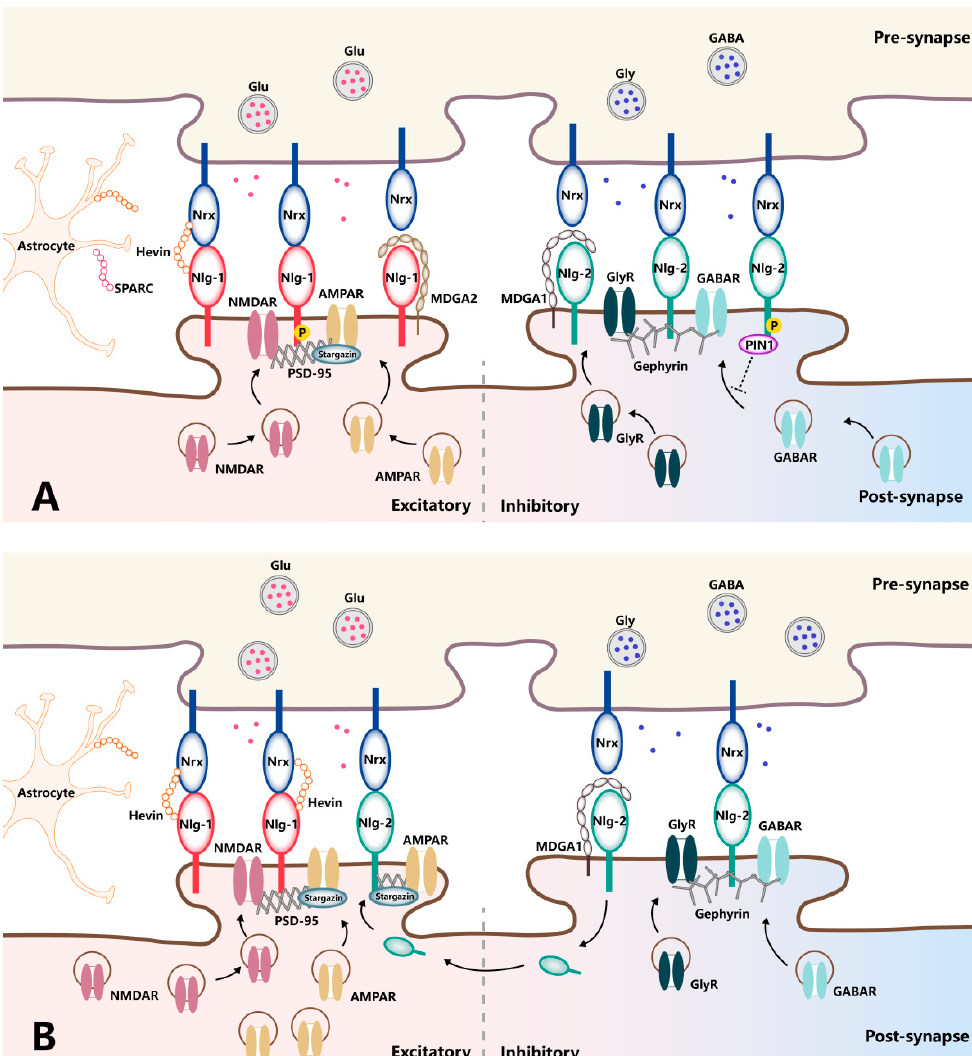
Figure 2. Schematic diagram of trans-synaptic interaction between neurexins and neuroligins in normal and pathologic pain. ( A ) In normal conditions, Nlg-1 and Nlg-2 contribute differently to the function of excitatory and inhibitory transmissions, respectively, in front of corresponding presynaptic Nrxs. Nlg-1 favors the functional modulation of glutamatergic synapses by recruiting NMDARs via the PSD-95 scaffold and trapping surface-diffusing AMPARs by binding with PSD-95 and stargazing. Nlg-2 recruits GABARs or glycine receptors through a specific interaction with gephyrin. The mechanistic importance of Nrx–Nlg is associated with a range of proteins capable of modulating their interaction at the synaptic cleft, in which hevin and SPARC directly in- teract with Nrx and Nlg, while MDGAs occupy the interaction site between Nrx and Nlg and, thereby, block Nrx–Nlg interaction. ( B ) In pathologic pain, Nlg-1, as well as the recruitment of corresponding excitatory glutamatergic receptors, is upregulated in the context of pathological pain. Meanwhile, traditionally inhibitory Nlg-2 undergoes a fundamental shift in functionality from inhibition towards excitation, with an increase in co-localization with PSD-95 and subsequent AMPAR subunit targeting under the same condition.